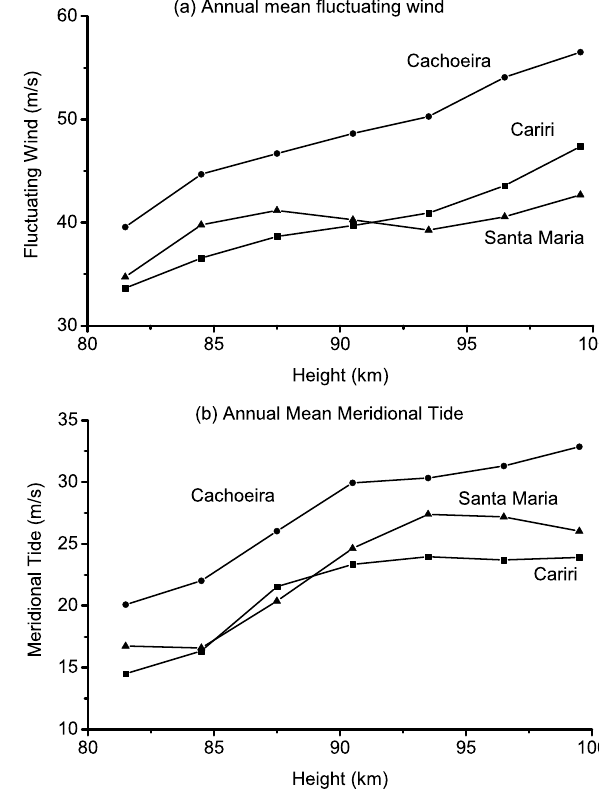
Fig. 6. Annual means of the meridional fluctuating winds and the diurnal tidal amplitude as a function of height for 2005, measured at 3 locations: (a) fluctuating wind, (b) diurnal tide.